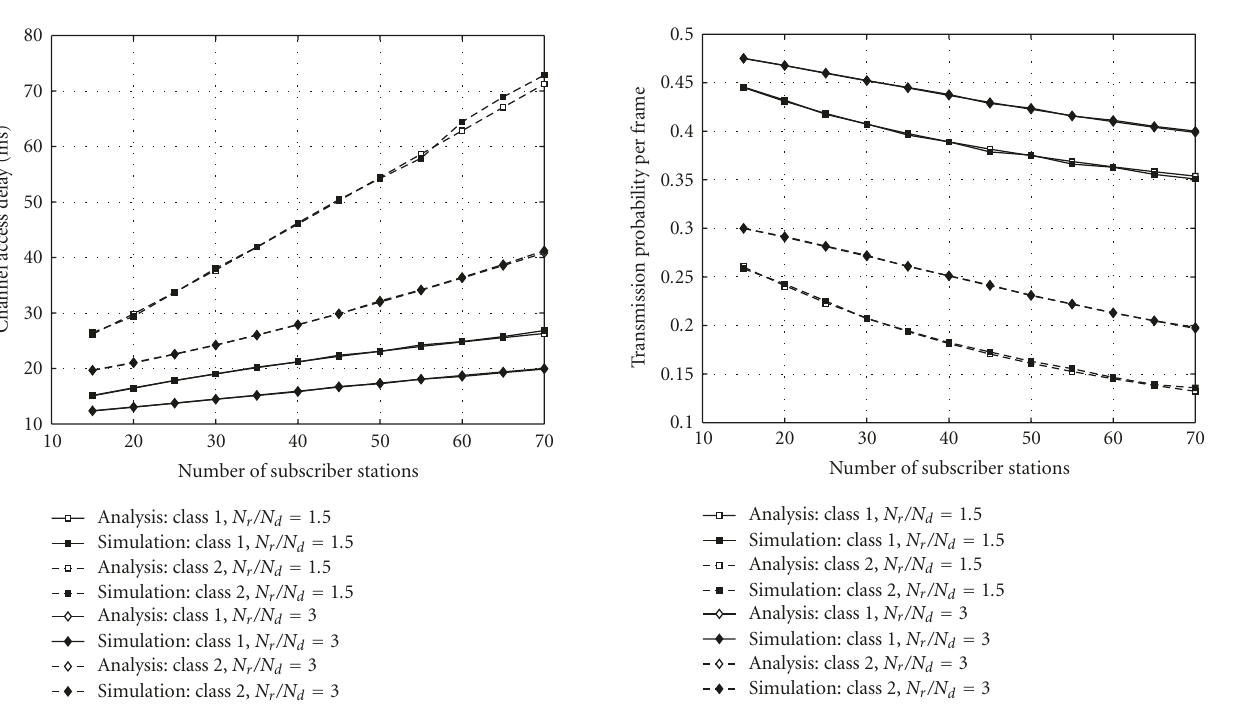
Figure 7: Delay of single SS versus the number of SSs with equal bandwidth allocation priority and di ff erentiated channel access